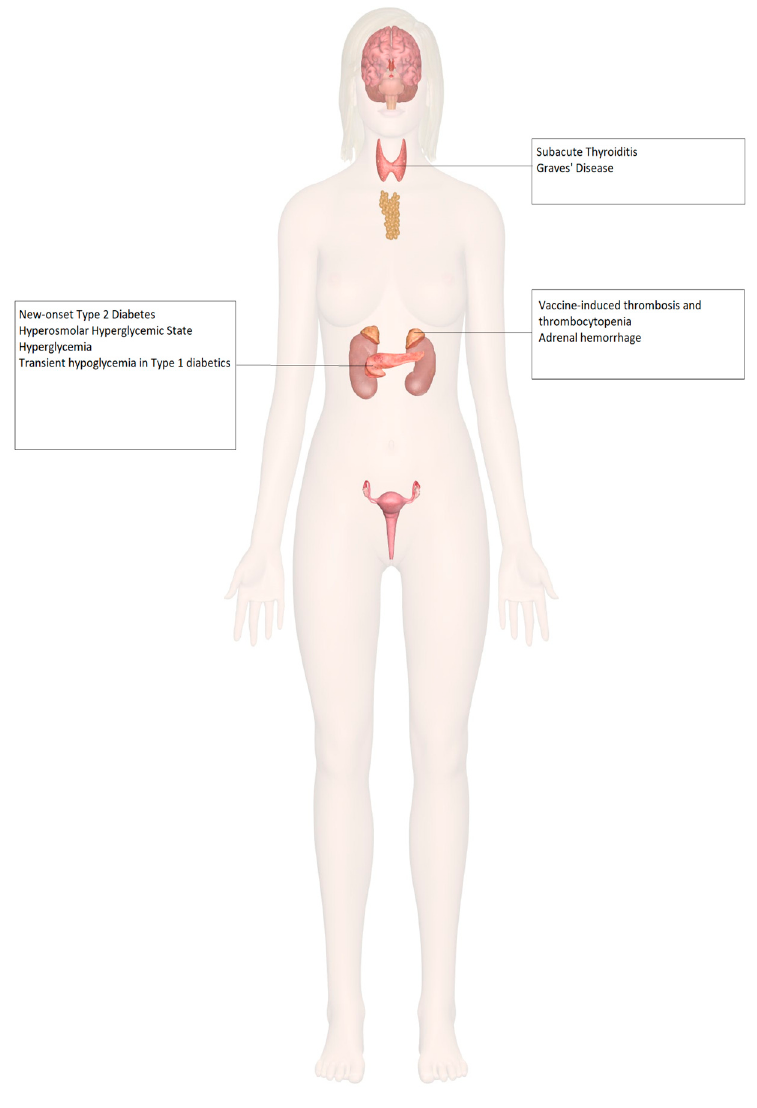
Figure 2. Endocrine organ involvement reported after COVID-19 vaccination.